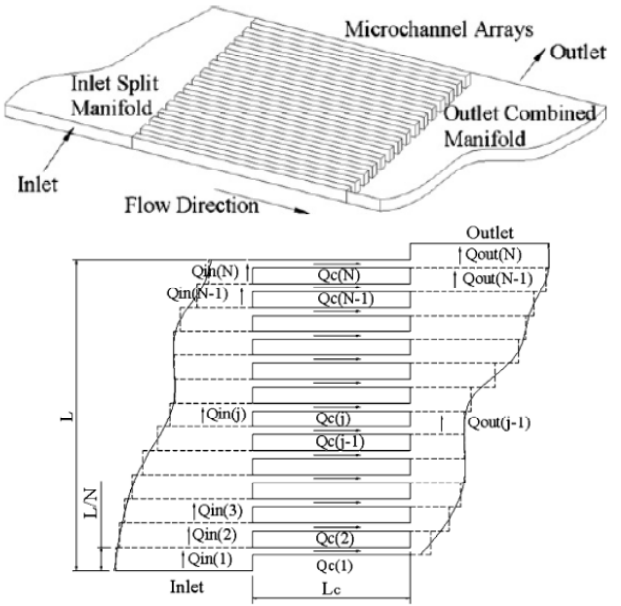
Figure 18. Microdevice design and analytical model. Reproduced from